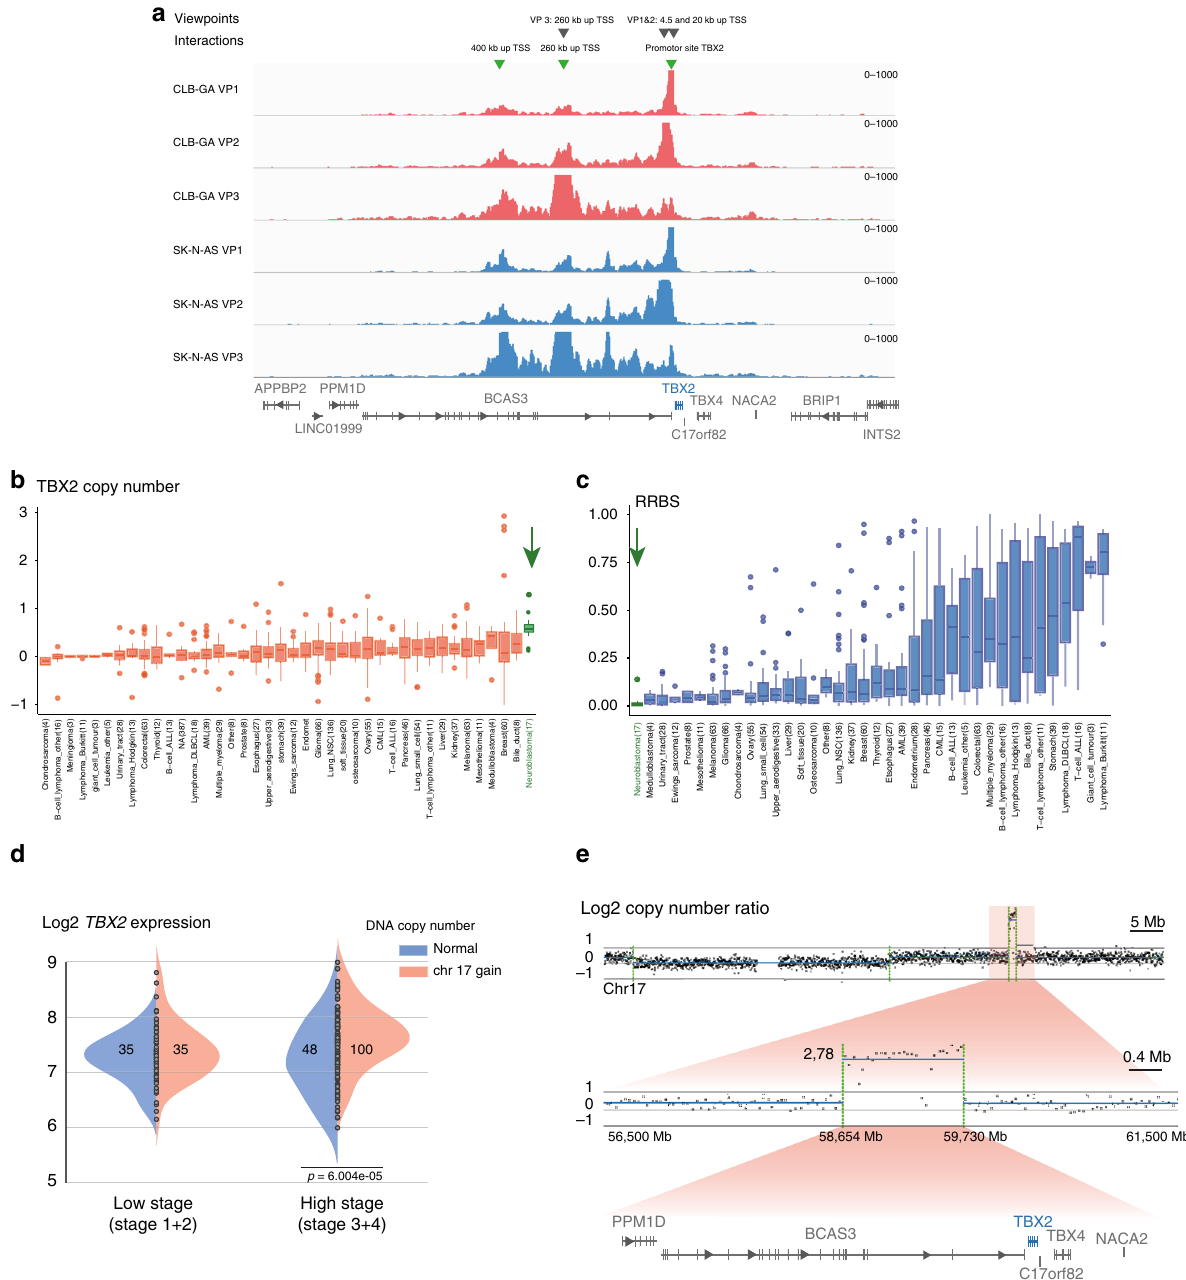
Fig. 2 TBX2 is targeted by rare focal ampli fi cations and marked by a SE. a 4C-seq analysis showing reciprocal interaction between the promotor site and SE upstream of TBX2 in the NB CLB-GA and SK-N-AS cell lines using three different viewpoints. b Copy number ratio of the TBX2 locus in a pan-cancer dataset (CCLE) with high copy number for TBX2 in NB (green arrow) as compared to cell lines from other tumor entities. Boxplots are drawn as a box, containing the 1st quartile up to the 3rd quartile of the data values. The median is represented as a line within the box. Whiskers represent the values of the outer two quartiles maximized at 1.5 times the size of the box. If 1 or more values outside of the whiskers are present, then this is indicated with a single mark dot next to the implicated whisker. Number of samples for every entity is depicted below the boxplot. c Genome-wide methylation pro fi le evaluated by reduced representation bisul fi te sequencing (RRBS) of the TBX2 locus in a pan-cancer dataset (CCLE). TBX2 is covered by a low methylation pro fi le in NB (green arrow) as compared to cell lines from other entities. Boxplots are drawn as a box, containing the 1st quartile up to the 3rd quartile of the data values. The median is represented as a line within the box. Whiskers represent the values of the outer two quartiles maximized at 1.5 times the size of the box. If one or more values outside of the whiskers are present, then this is indicated with a single mark dot next to the implicated whisker. Number of samples for every entity is depicted below the boxplot. d Signi fi cantly increased TBX2 expression levels in cases with both high stage disease (stage 3 and 4) and increased TBX2 copy number due to 17q gain (ANOVA, n = 218, p = 6.004e − 5, chr17 gain log2 ratio > 0.3). e Log2 copy number ratio of a region on 17q with a focal ampli fi cation encompassing the protein-coding genes PPM1D, BCAS3, TBX2, C17orf82, TBX4 , and NACA2 , in a primary NB tumor case (58,654 Mb — 59,730 Mb — hg19 — log2 ratio